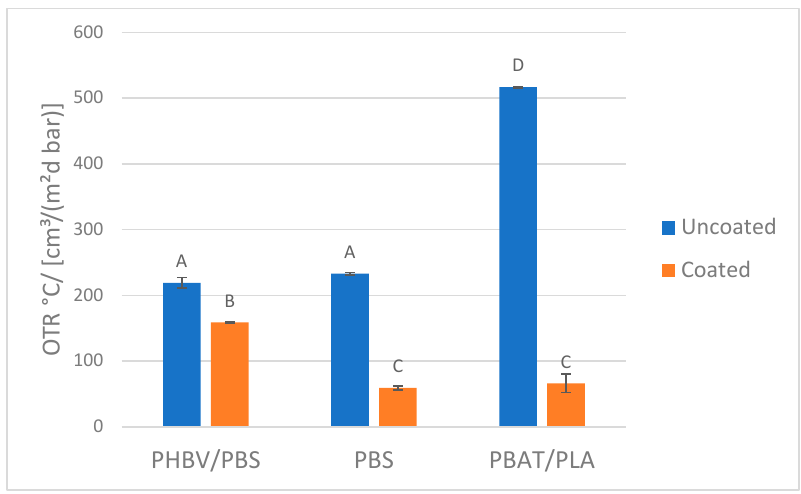
Figure 5. OTR values of coated and uncoated films. The same letter on the column means that values were not significantly different (confidence level 95%).